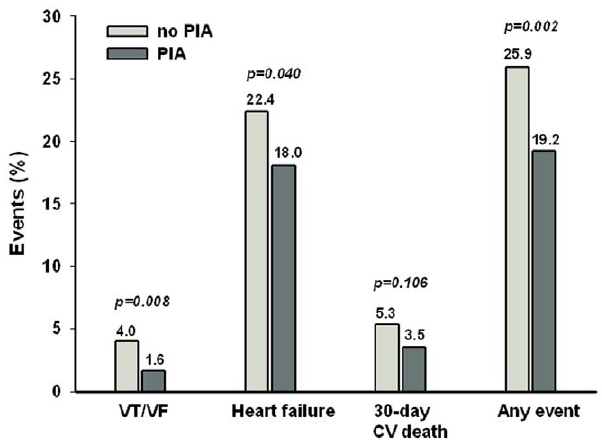
Figure 2. Cardiovascular events (%). CV: cardiovascular; VT/VF: ventricular tachycardia/ventricular fibrillation .